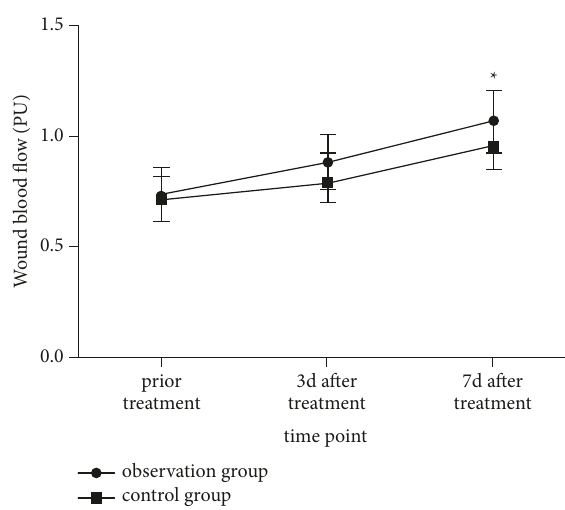
Figure 9: Comparison of wound blood flow between the two groups before and after treatment.